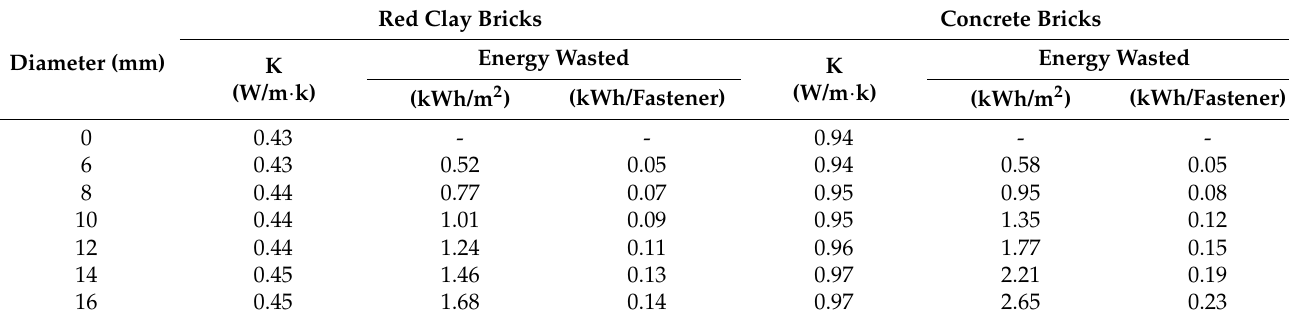
Table 3. Thermal conductivities and energy wasted at different numbers of fasteners.